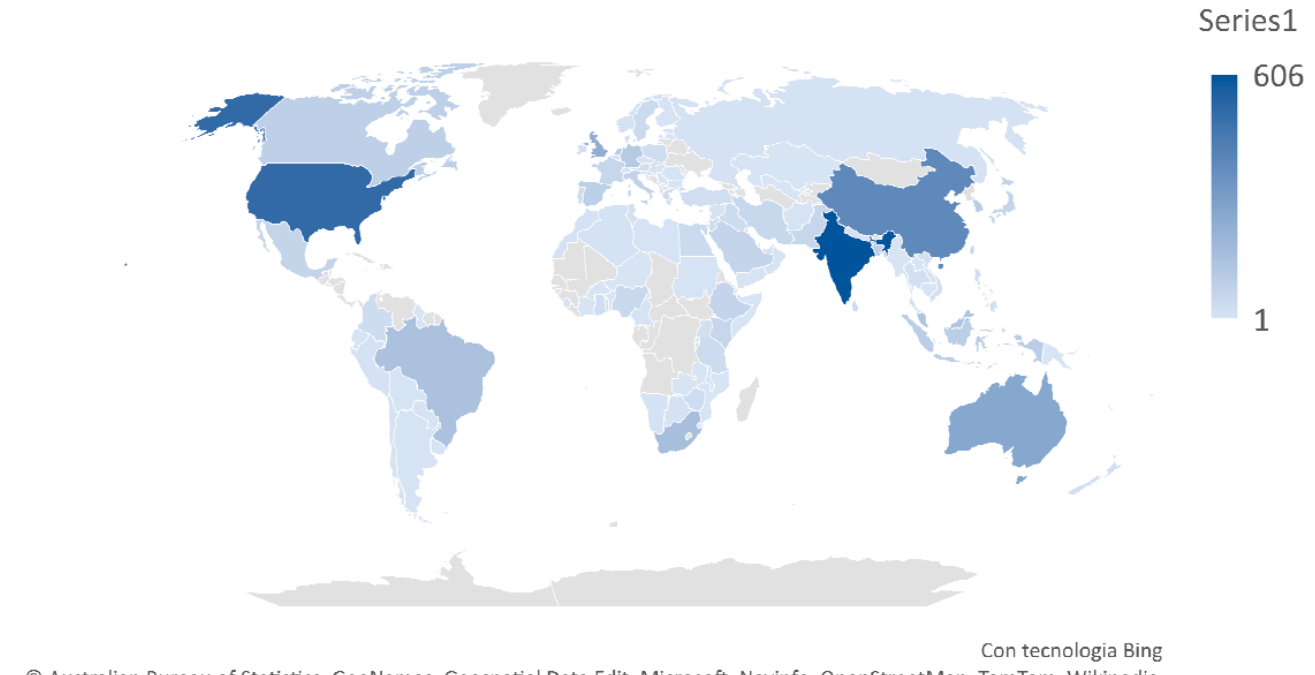
Figure 2. World distribution of manuscripts corresponding to the keyword “rainwater harvesting” (Scopus search, 6 February 2023) .